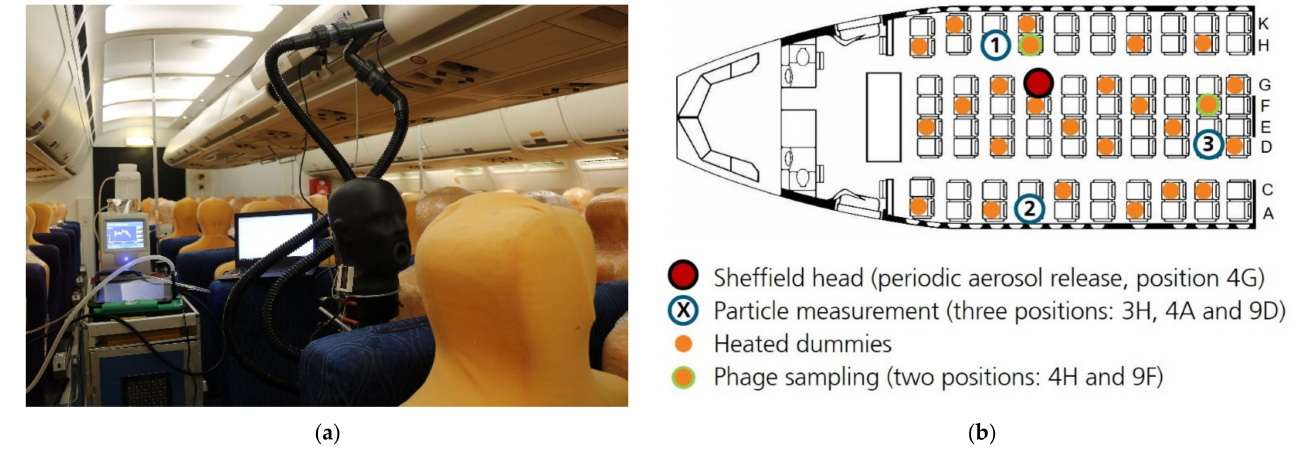
Figure 2. Aircraft cabin and positions: ( a ) interior view; ( b ) positions of the Sheffield head, three particle counters, two air samplers for phage plaque assay, and 25 heated dummies.